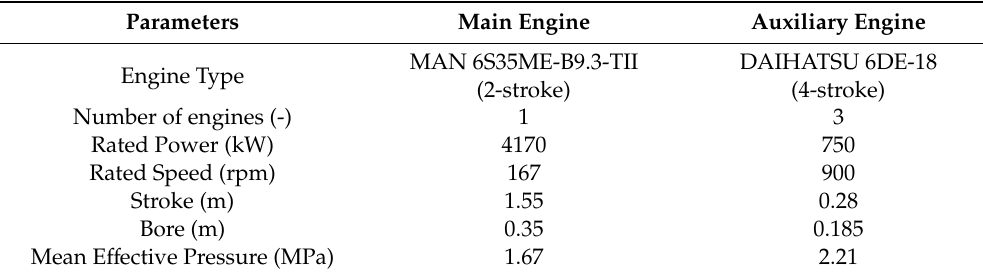
Table 2. Particulars of the main engine and auxiliary